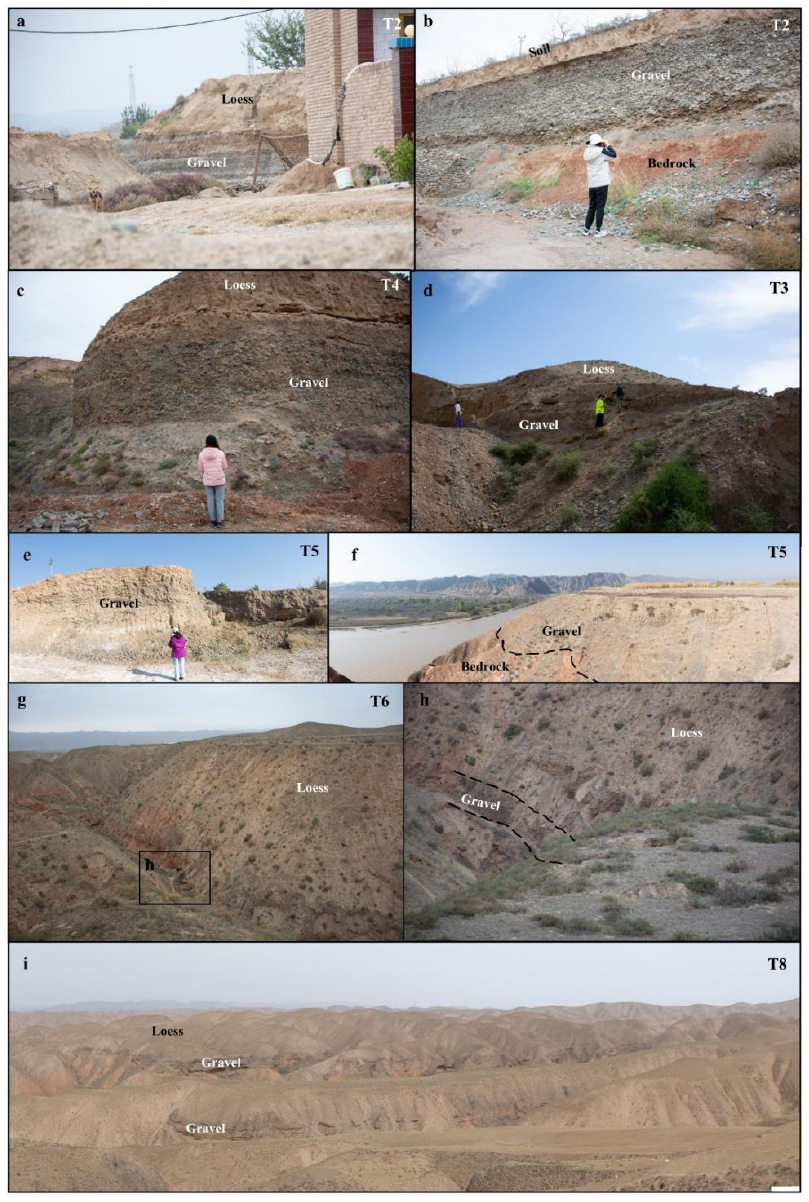
Figure 7. Field photos of each terrace at the BCC section. ( a – g , i ) show terraces T2, T4, T3, T5, T6, and T8, respectively. ( a , b ) show that the same terrace (T2) at different sites has a different thickness of flood sand/silt and loess. ( h ) Shows that the top of T5 may be eroded. The height of the top of the gravel layer of the lower terraces T2, T3 and T5 above the modern Yellow River are equivalent in both sections. In summary, at least 8 Yellow River terraces were identified in the Wufo Basin with the top of the gravel layer above the floodplain of the modern Yellow River at 10–20 m, 30 m, 34 m, 70 m, 115 m, 150 m, and 190 m, respectively (Figures 3 and